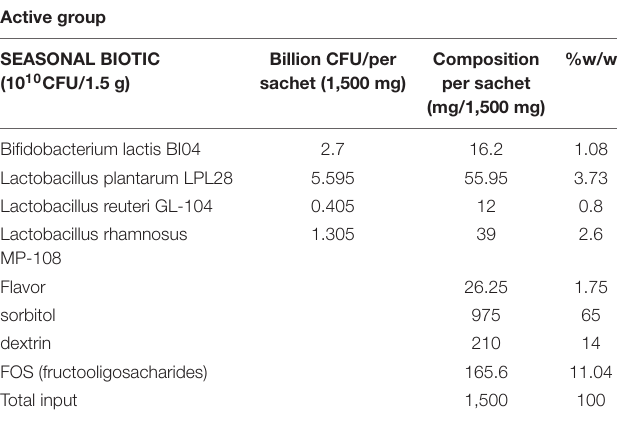
TABLE 1 | Probiotic active powder composition. Active